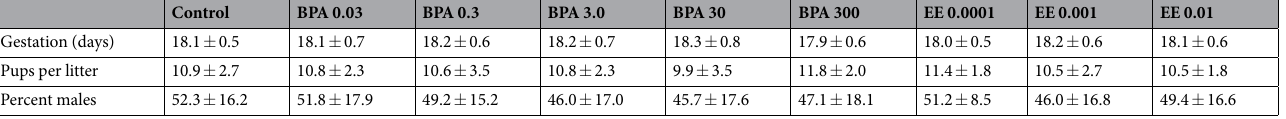
Table 4. Litter Size and Sex Ratio. Values represent mean ±